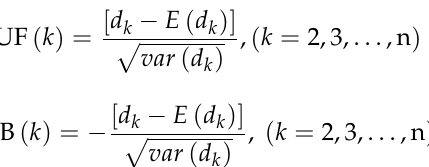
y = 0.029x − 48.907 Figure 4. Average annual temperature and tendencies in the Lanhe Watershed. （ 1967–1990 ）